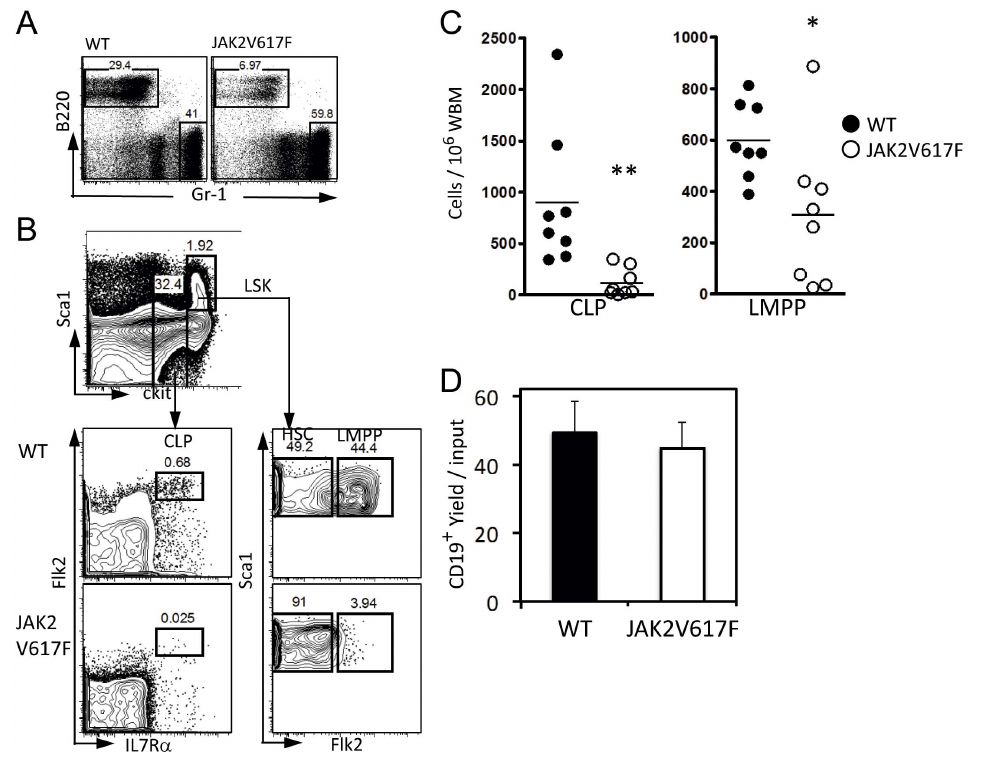
Figure 5. Lymphoid progenitors are depleted in JAK2V617F transgenic mice. ( A ) Whole bone marrow cells were characterized by staining with B220 (lymphoid specific) and Gr1 (myeloid specific) antibodies. ( B ) The c-kit L u CLP fraction was defined by staining for Flk2 and IL-7R a (left panels). The LSK fraction was divided for enumeration of Flk2 Hi LMPP. ( C ) Percentages of CLP (left panel) and LMPP (right panel) are shown. The data are representative of those obtained in three independent experiments (N=8). ( D ) Lymphoid potential is similar between WT and JAK2V617F CLP. CLP were cultured in serum- and stromal cell-free culture for 7 days. Production of differentiated CD19 + cells were calculated as yields per input progenitor. The data are representative of those obtained in two independent experiments p , 0.01(**), p ,